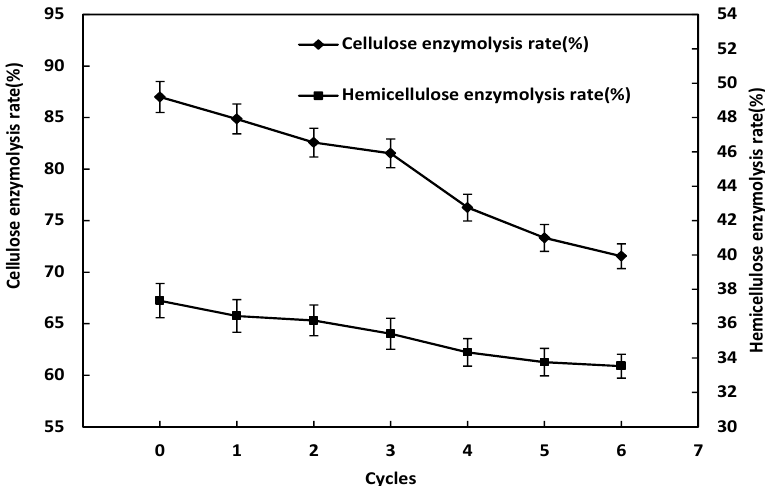
Figure 2. E ff ect of di ff erent times of alkaline black liquor circulation combined with ozone pretreatment Figure 2. Effect of different times of alkaline black liquor circulation combined with ozone on enzymatic hydrolysis pretreatment on enzymatic hydrolysis rate.